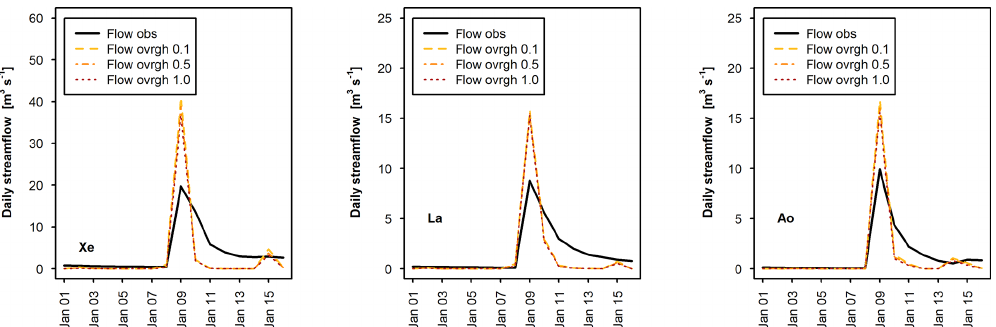
Figure 4. Hydrographs obtained at three different watersheds for OVRGH values of 0.1 (Flow ovrgh 0.1), 0.5 (Flow ovrgh 0.5) and 1.0 (Flow